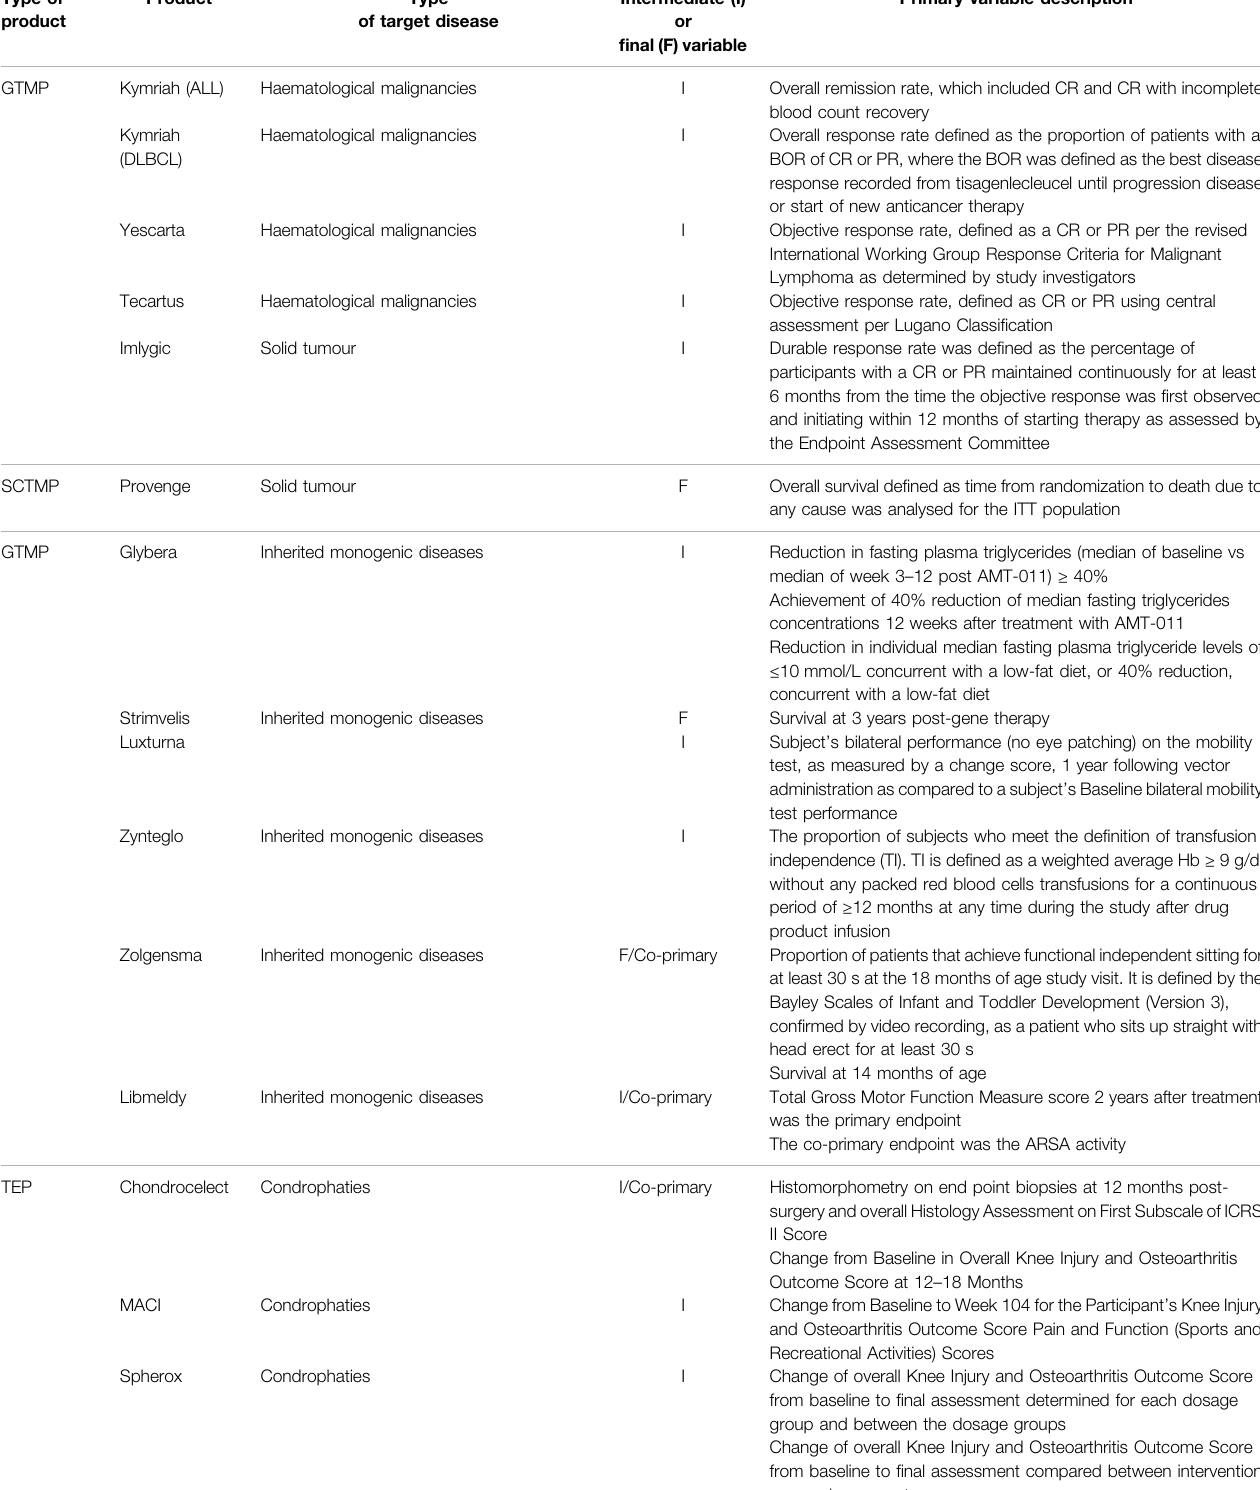
TABLE 5 | Primary clinical variables of pivotal clinical trials for the approved ATMPs in the European